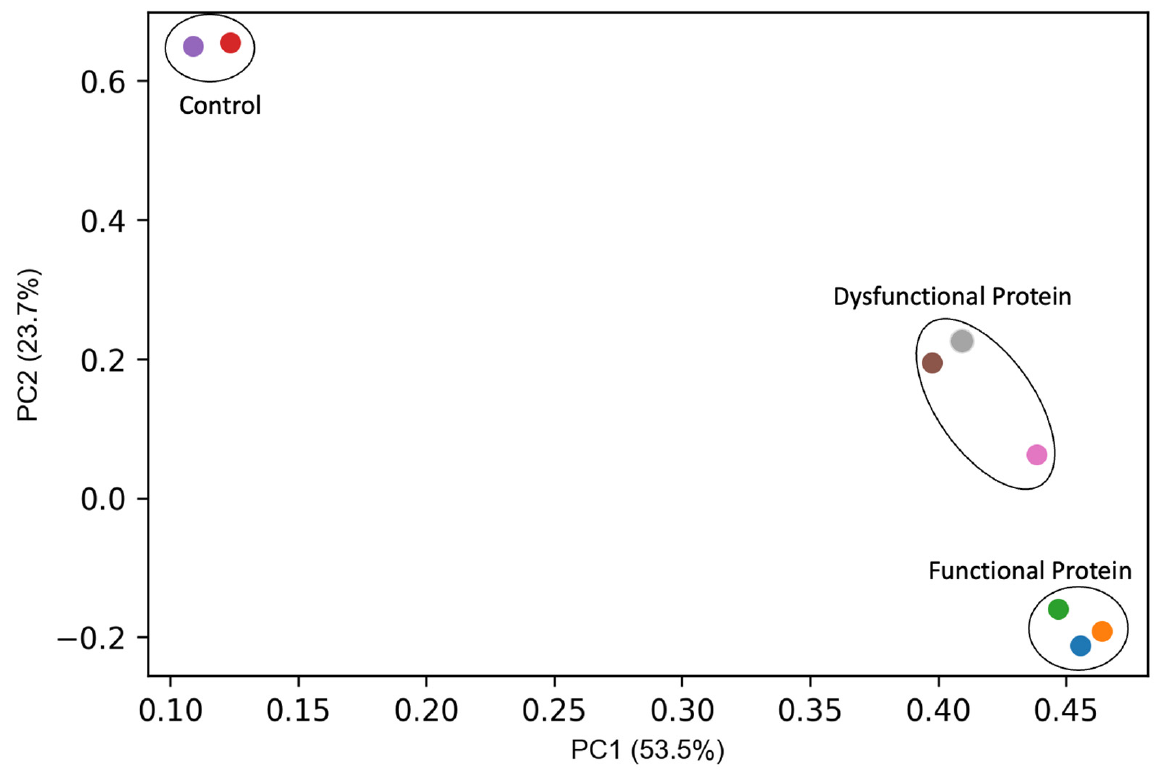
Figure 5. A representative PCA plot illustrating the ability of MIMS to distinguish between the volatile profiles of uninoculated media, i.e., control and growth media with cells expressing the functional YdgR and cells expressing the dysfunctional protein (YdgR mutant).